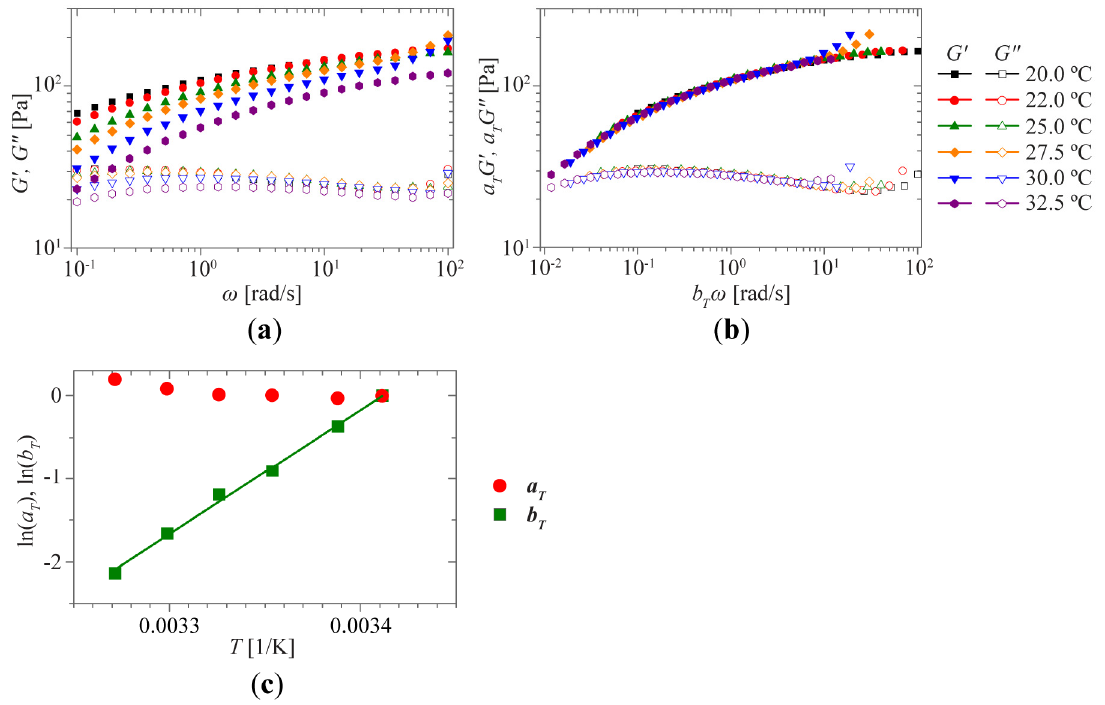
and b for the moduli G ′ and G ″ T T / R . a